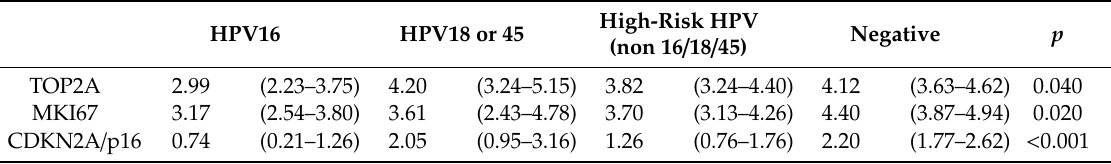
Figure 4. Boxplots of the levels of ( a ) TOP2A; ( b ) MKI67; ( c ) CDKN2A / p16 according to the HPV genotype. The values shown are ∆∆ Ct [(cycle threshold target-cycle threshold reference sample) − (cycle threshold SiHa-cycle threshold reference SiHa)]. The black line within the box represents the median; the whiskers represent the minimum and maximum values that lie within 1.5 interquartile ranges from the end of the box. Values outside this range are represented by black dots. Table 4. mRNA levels of TOP2A, MKI67 and CDKN2A/p16 according to the HPV genotype. The values shown are ΔΔ Ct [(cycle threshold target-cycle threshold reference sample) − (cycle threshold SiHa-cycle threshold reference SiHa)] and 95% confidence interval.